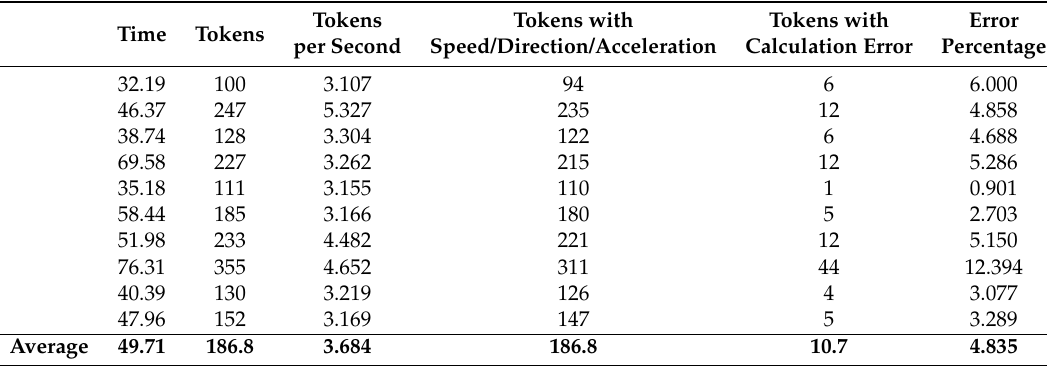
Figure 10. Result of the application of the Anticipation Analysis. Table 2. Errors in the accuracy